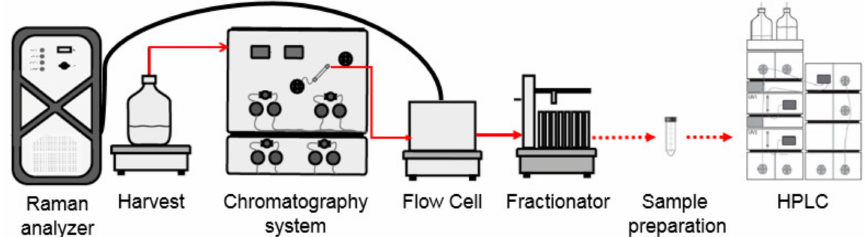
Figure 2. Schematic illustration of the experimental set up to perform chromatographic breakthrough runs and collecting synchronized Raman measurements and breakthrough